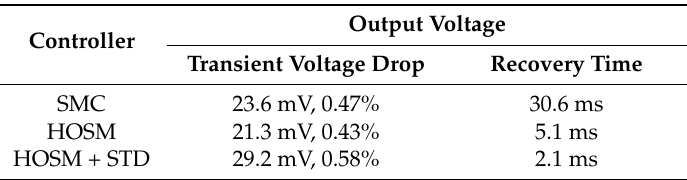
Table 5. Output load disturbance analysis results.